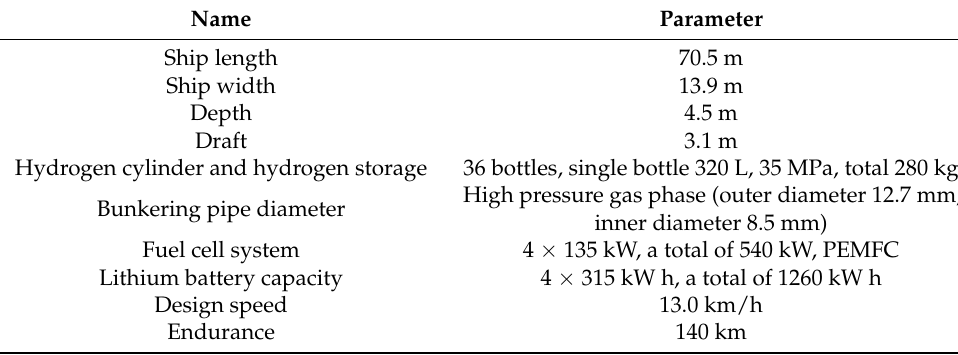
Table 1. The main parameters of the hydrogen powered